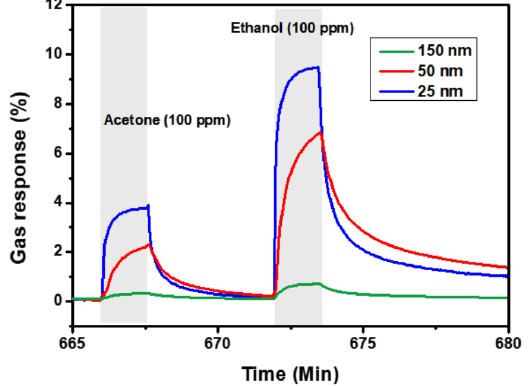
Figure 22. Gas sensor response of Ti 3 C 2 T x MXene with different thicknesses to acetone and ethanol at the concentration of 100 ppm. Reprinted with permission from [6]. Copyright © 2018, American Chemical Society.